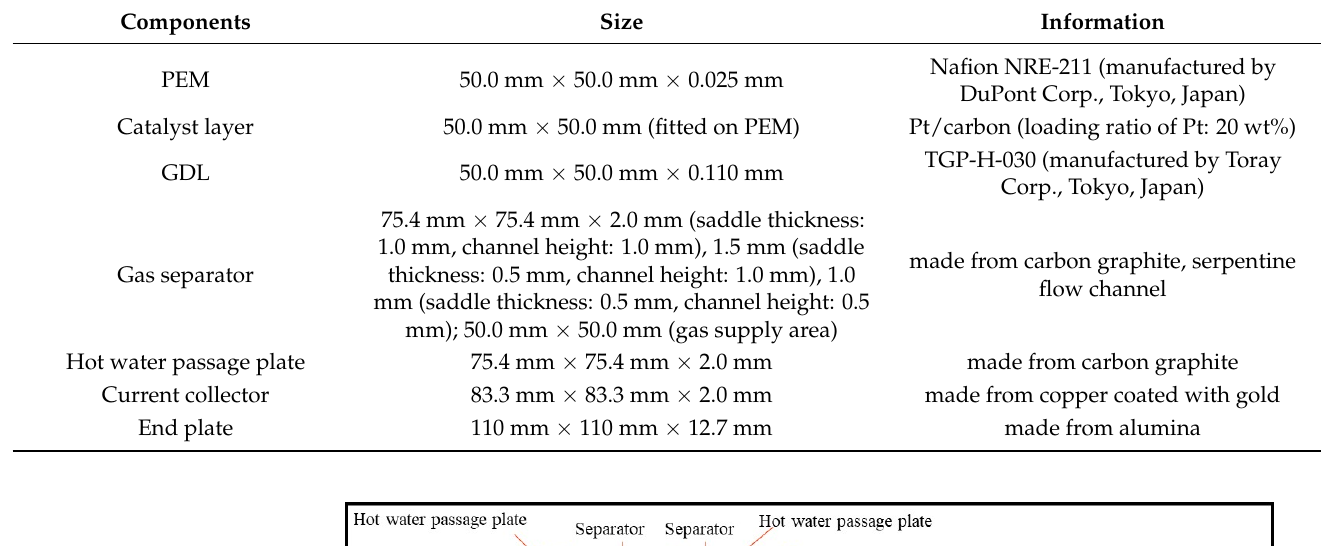
Table 1. Specifications of cell components of a single PEFC. The separator size was changed as a main parameter in this study.